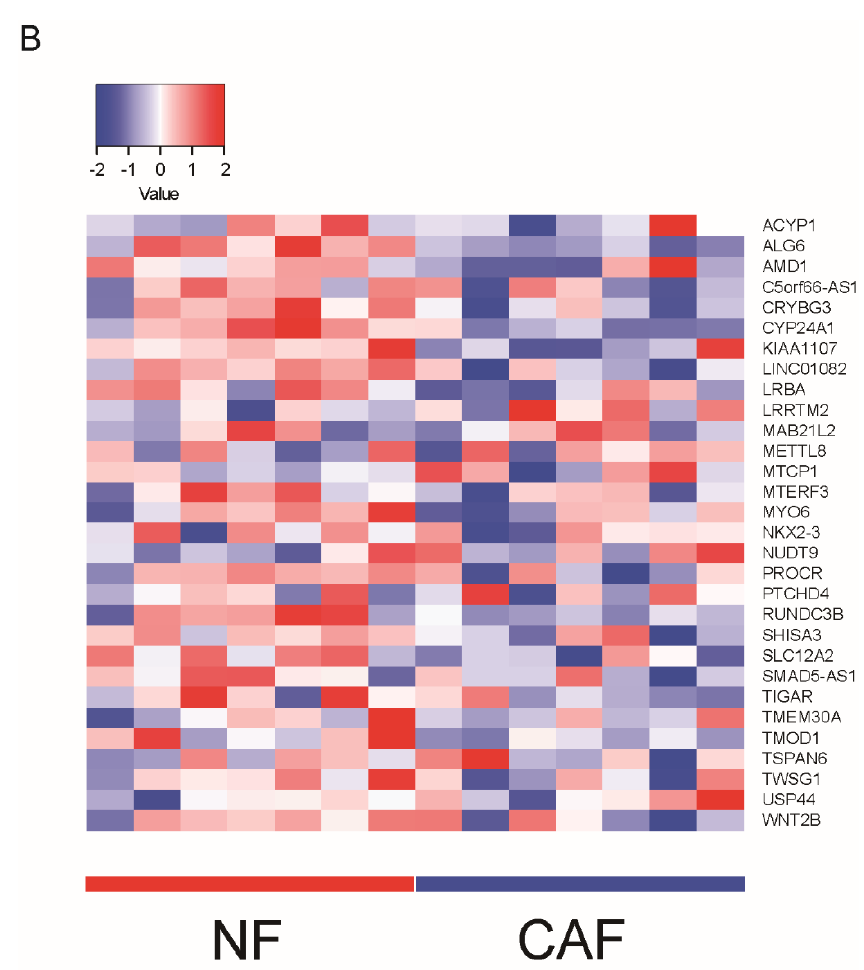
Figure 1. Unique features of colon submucosal fibroblasts. ( A ) Gene set enrichment analysis (GSEA) was performed using the microarray datasets of colon normal fibroblasts (NFs) and cancer-associated fibroblasts (CAFs). Expression profiling data of colon NFs and colorectal CAFs were obtained from the GSE70468 dataset. A colon SMF-specific signature was identified by differential expression analysis between the colon SMFs (4 samples) and non-GIFs (31samples) obtained from the GSE63626 dataset. SMFs: submucosal fibroblasts. GIFs: gastrointestinal fibroblasts. ( B ) Heatmap of the relative expression levels of 30 leading-edge genes obtained by GSEA.